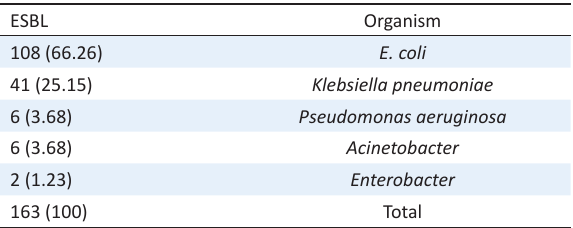
Table 2. The prevalence of ESBL bacteria isolated from positive urine culture specimens ESBL